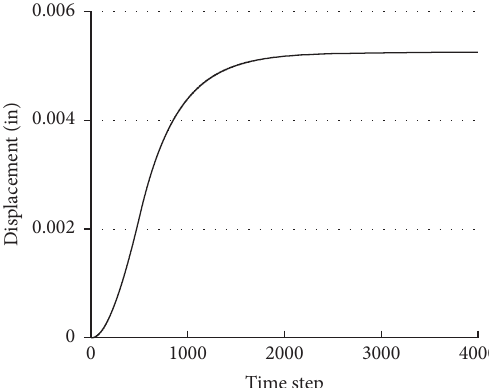
Figure 5: Convergence process of vertical displacement for outer-edge node.